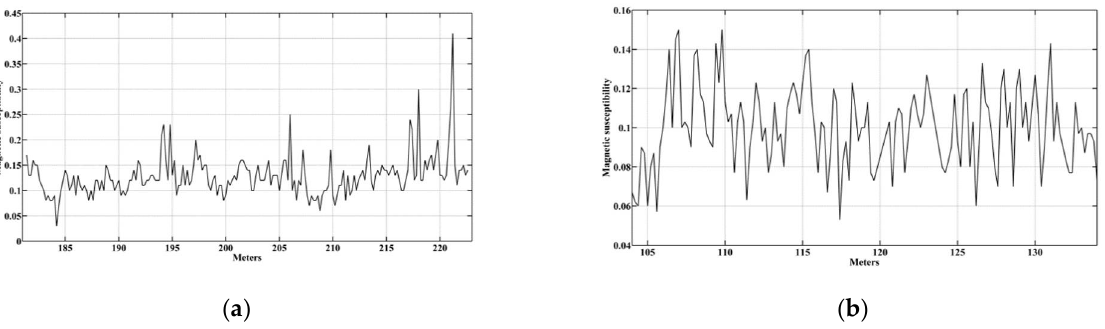
Figure 2. Magnetic susceptibility of deposits of the Zhelezny Rog Cape section: ( a ) Lower-Upper Pontian; ( b ) Lower Maeotian.